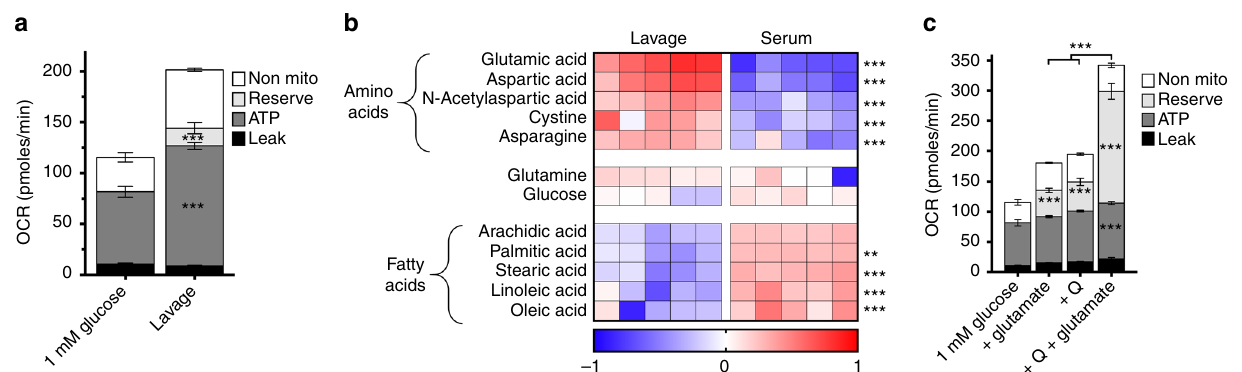
Fig. 2 Peritoneal tissue-resident macrophage mitochondria can be fuelled through abundant peritoneal glutamate. a Bar graph showing the effect of 5× diluted peritoneal fl uid (1 mM glucose media lavage followed by cell and protein depletion) in comparison to 1 mM glucose media on mitochondrial parameters in peritoneal tissue-resident macrophages. Data were from one experiment ( n = 5 – 6 separate wells per group) and analysed by paired two-way ANOVA (interaction p < 0.0001) with Sidak ’ s post-tests. b Heat-map showing the log10 difference from the average metabolite peak areas from gas chromatography-mass spectrometry analysis of the most enriched amino acids in peritoneal lavage fl uid and the fatty acids in blood serum, glucose and glutamine act as a reference. Data show fi ve independent samples that were analysed by two-way ANOVA (interaction p < 0.0001) with Sidak ’ s post- tests. c Stacked graph detailing the addition of glutamine (Q, 0.25 mM) and glutamate (0.5 mM) to peritoneal tissue-resident macrophages and resulting changes in mitochondrial parameters. Data are from the same experiment as a , but increases in mitochondrial function after glutamate and Q represent three independent experiments, data were analysed by two-way ANOVA (interaction p < 0.0001), Sidak ’ s post-tests are indicated within the bars for parameters vs 1 mM glucose and above representing the synergistic effect of glutamate and Q. All error bars denote mean ±